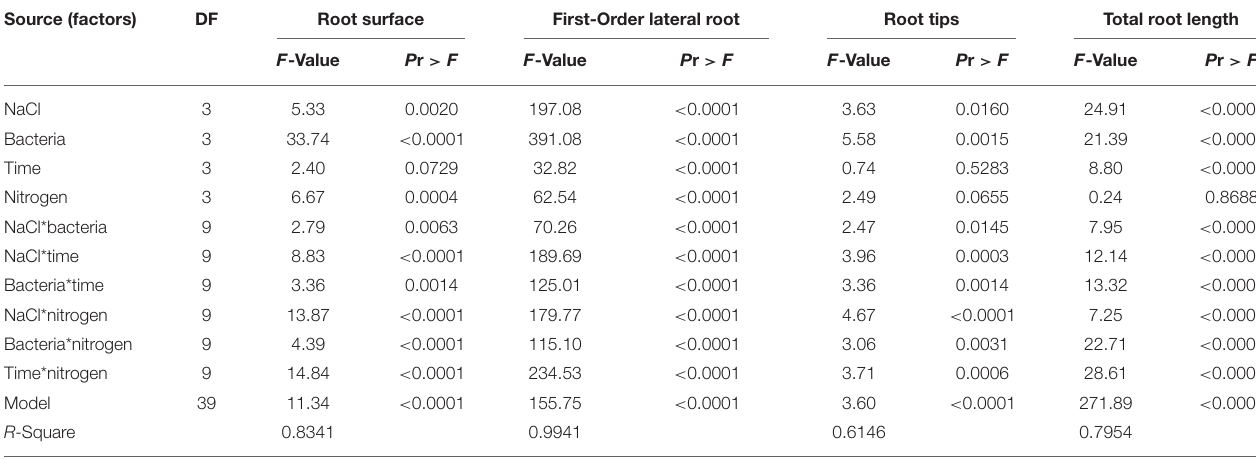
TABLE 4 | Variance analyses for the models of root surface, number of first-order lateral root, root tips, and total root length of the seedlings, for each experimental factor and among them. Source (factors)